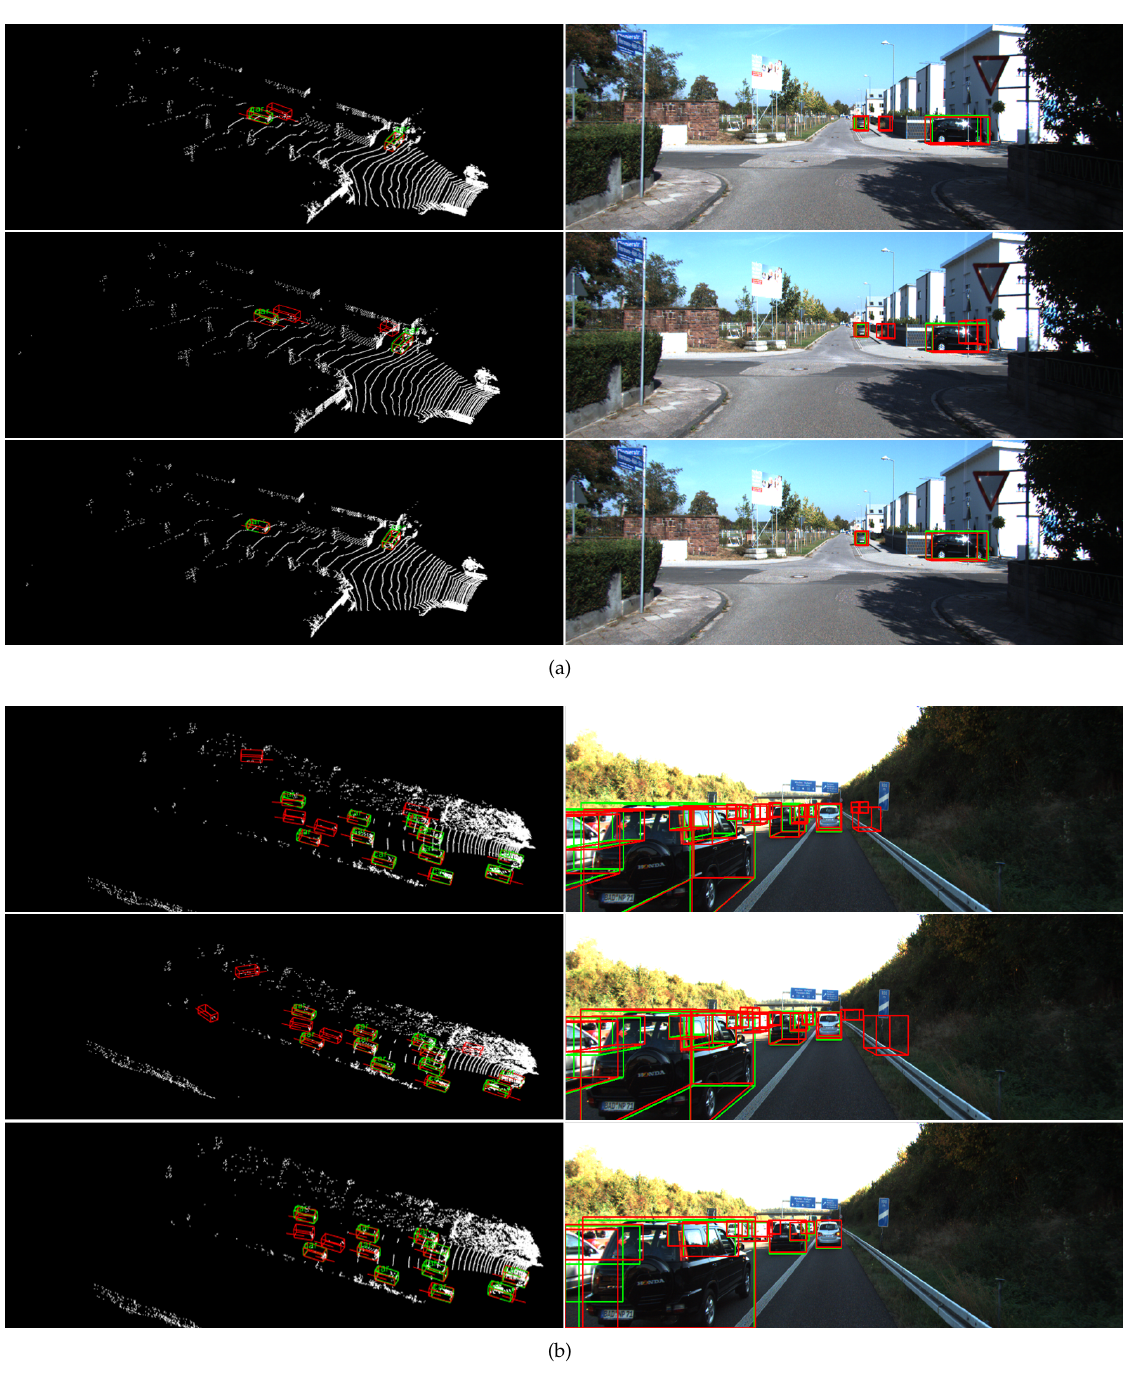
Figure 9. Comparison of detection results from Pointpillars [13] ( top ), SECOND [12] ( middle ), and ours ( bottom ) for two different scenes ( a , b